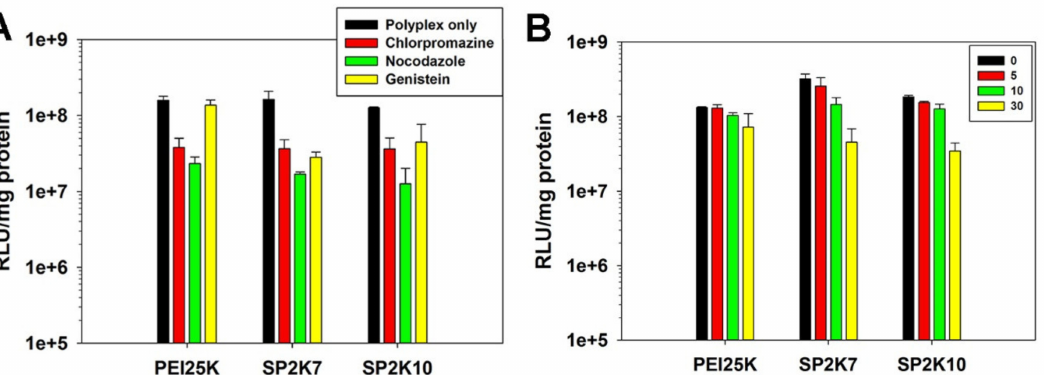
Figure 8. Transfection results using cellular uptake inhibitors in HeLa cells. The numbers in ( B ) indicate the concentration of SC-236 ( µ M). Error bars indicate the standard deviations ( n =